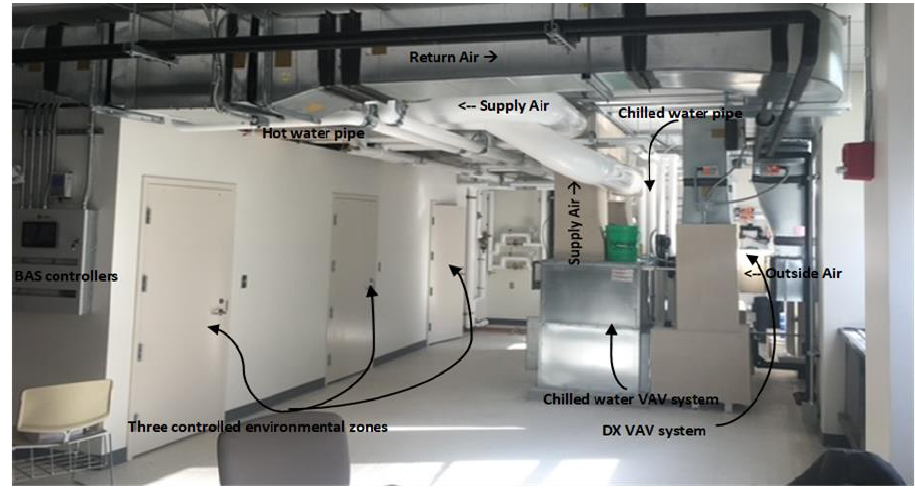
Figure 5. BEAST lab layout.